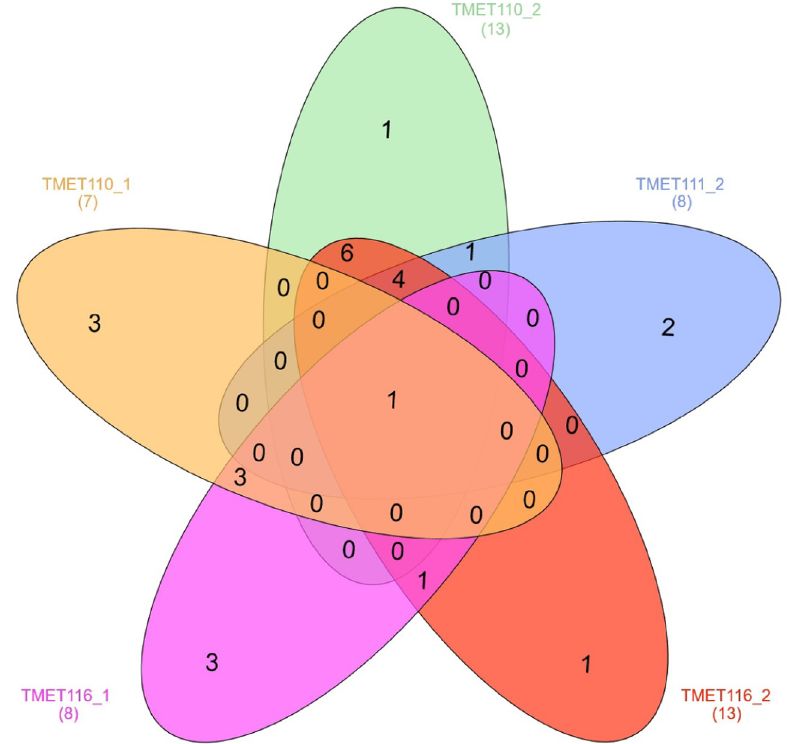
Fig 4. Number of shared mQTL between five correlated metabolites. All metabolites share one mQTL, the major mQTL on chromosome 1H.